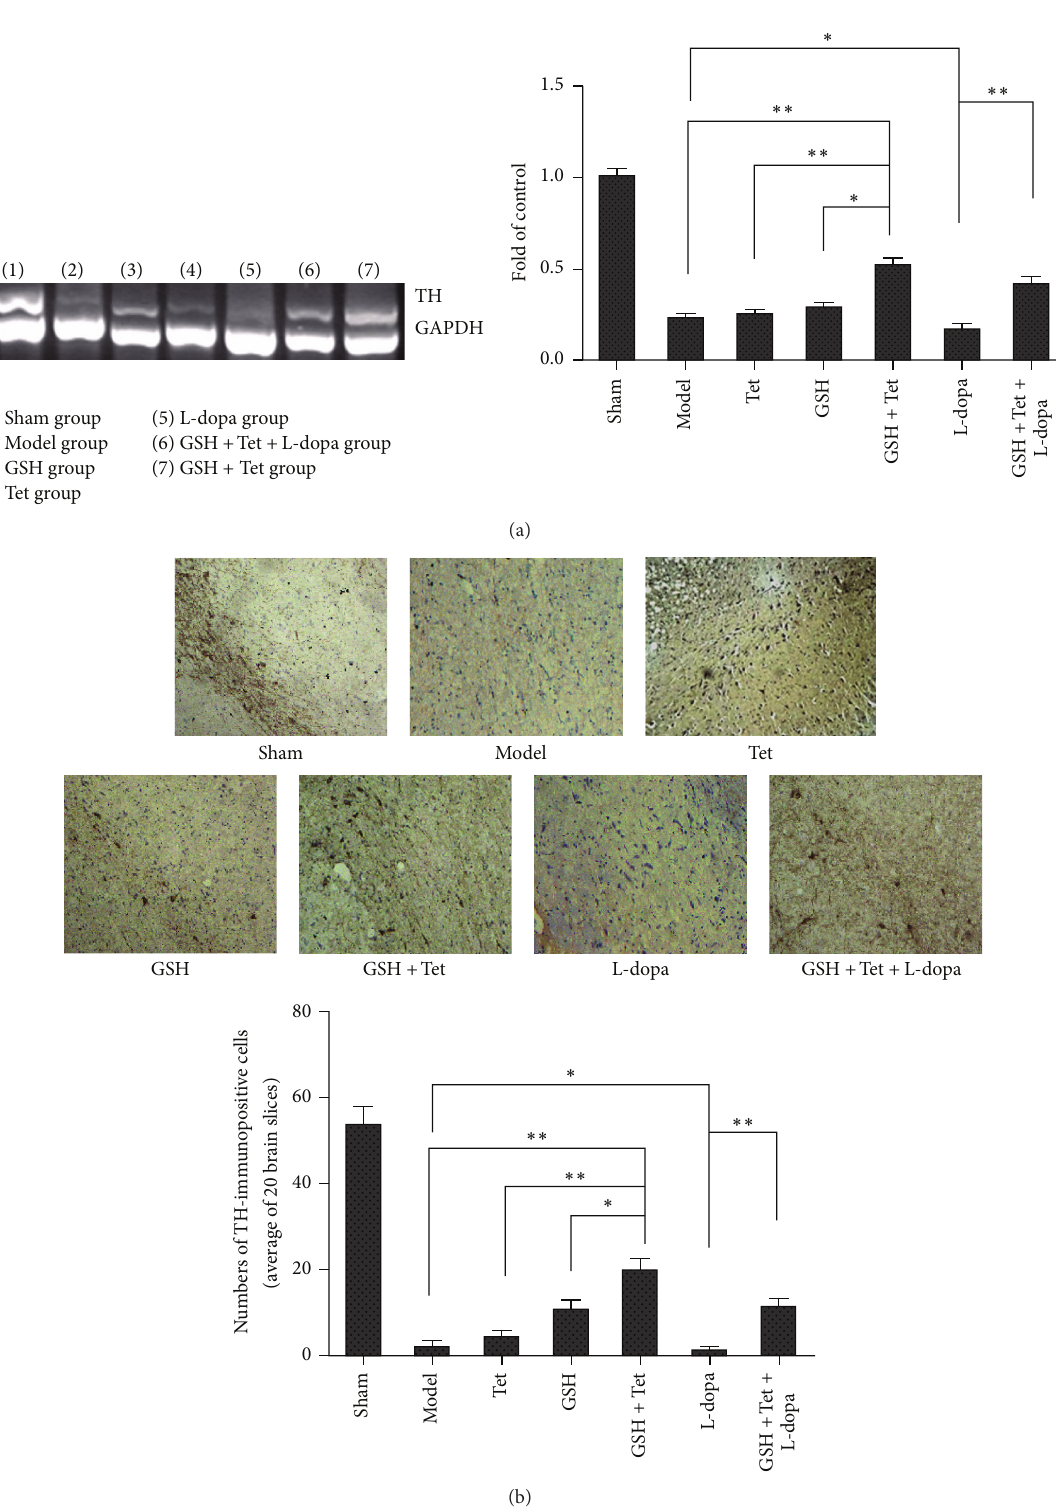
Figure 3: Effects on the tyrosine hydroxylase (TH) gene expression (a) and TH-positive neurons in the striatum of lesion sides (b). The expression of TH mRNA was examined by Reverse Transcriptase Polymerase Chain Reaction (RT-PCR). GAPDH served as an internal control.THDNAquantificationwasobtainedbydensitometricanalysisoftheDNAbandarea.TheTH-immunopositiveneuronalcellsurvival was examined using immunohistochemical staining. Statistical histogram of the number of surviving TH-positive neurons represents the average of 20 brain slices from each group. Each bar represents mean ± standard deviation (SD) for six animals per group. ∗ 𝑝 < 0.05 , ∗∗ 𝑝 < 0.01 , comparison among different groups after drug